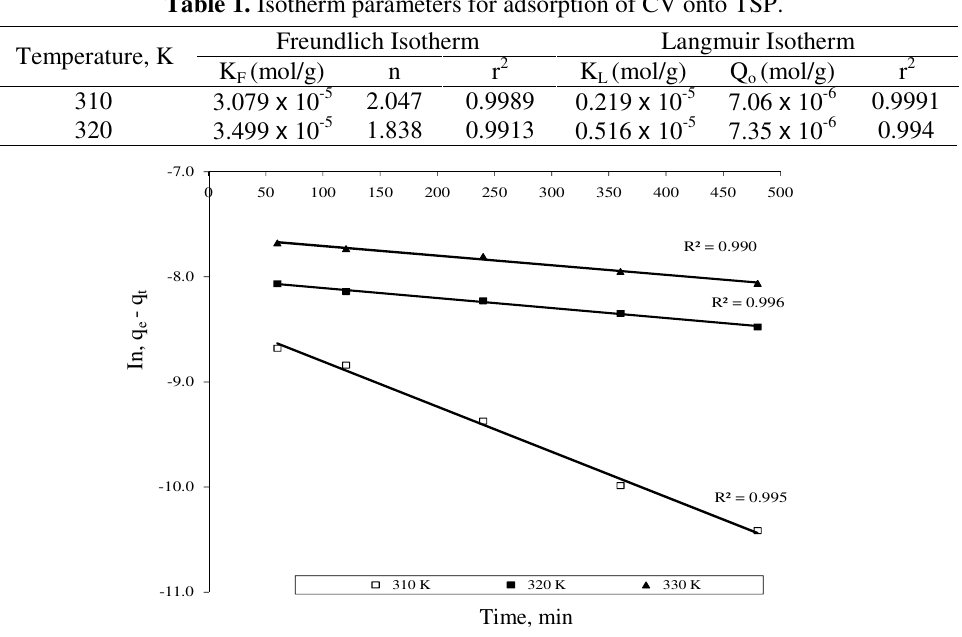
Figure 8 (a). Pseudo-first order